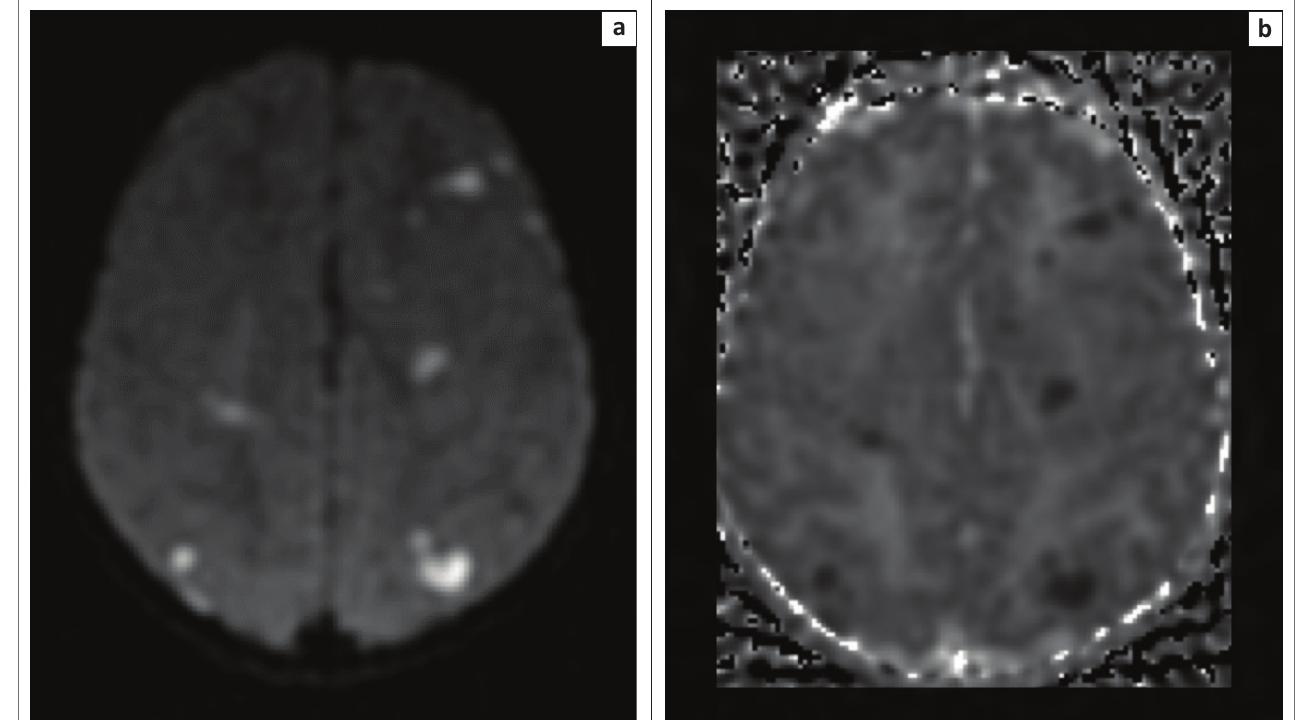
FIGURE 17: A 3-day-old baby boy with neonatal seizures after grade 2 neonatal hypoxic ischemic brain injury. (a) The diffusion B-1000 trace sequence and (b) the corresponding ADC map. Note that the watershed territory involvement in this child is asymmetric, and this is often seen in partial prolonged ischemia subtype.